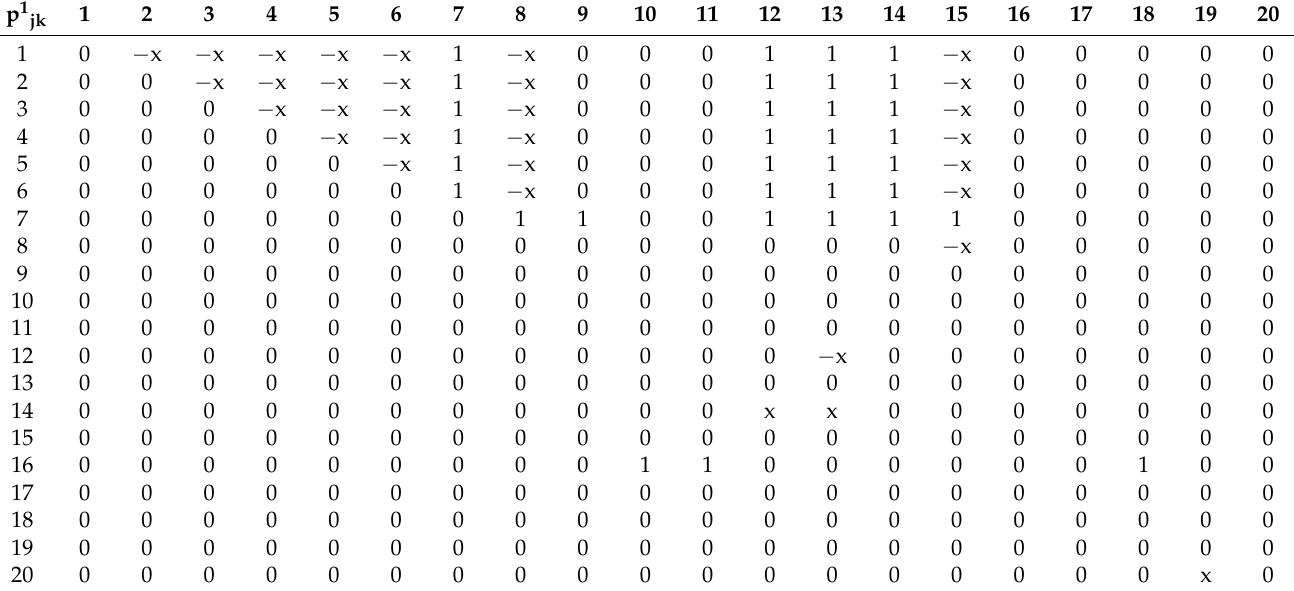
Table 1. The matrix of the relationships between nodes of the dryer drum.